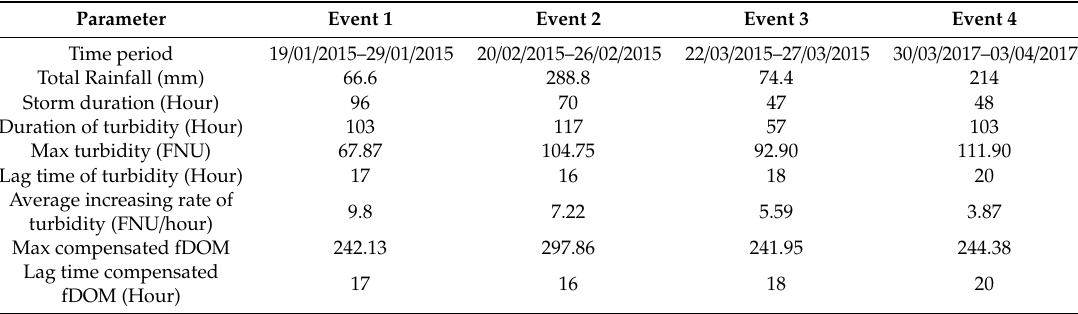
Table 1. Relevant parameters in Tingalpa Reservoir in extreme